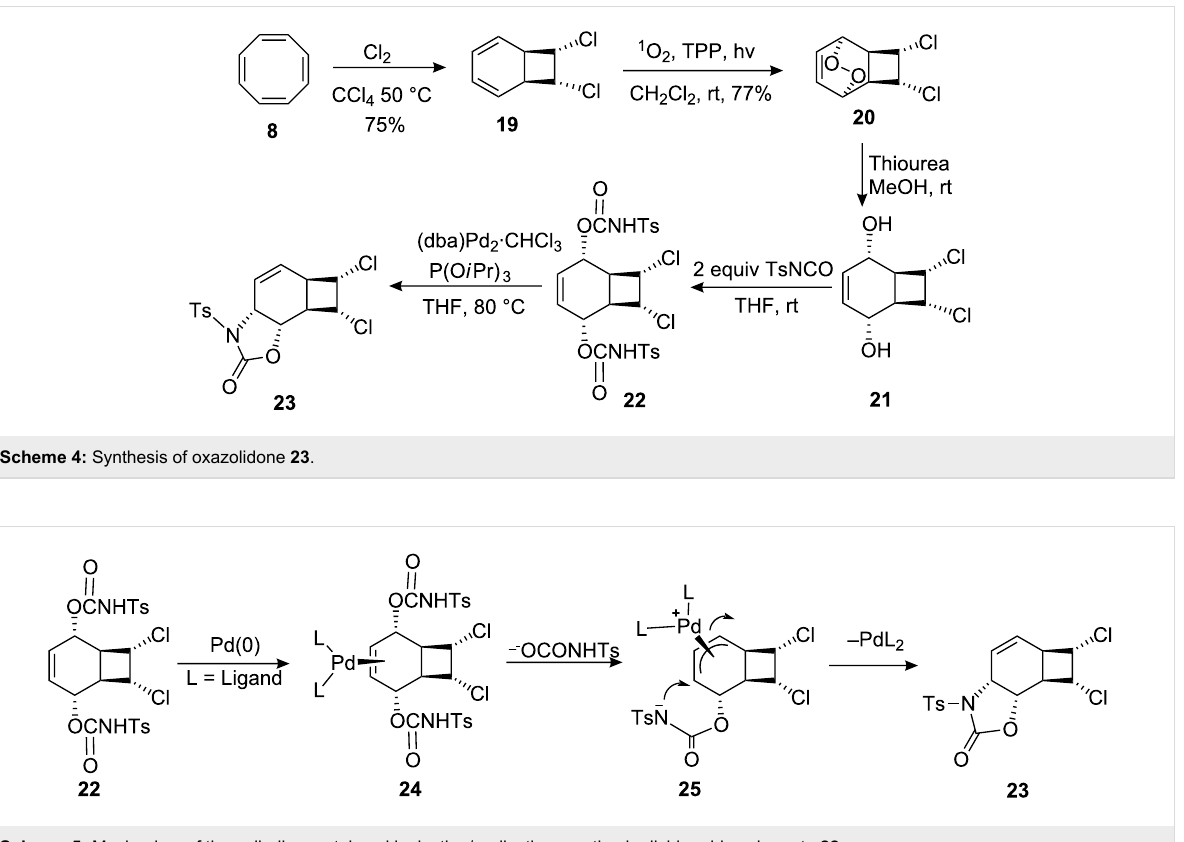
Scheme 5: Mechanism of the palladium-catalyzed ionization/cyclization reaction in dichloro biscarbamate 22 .